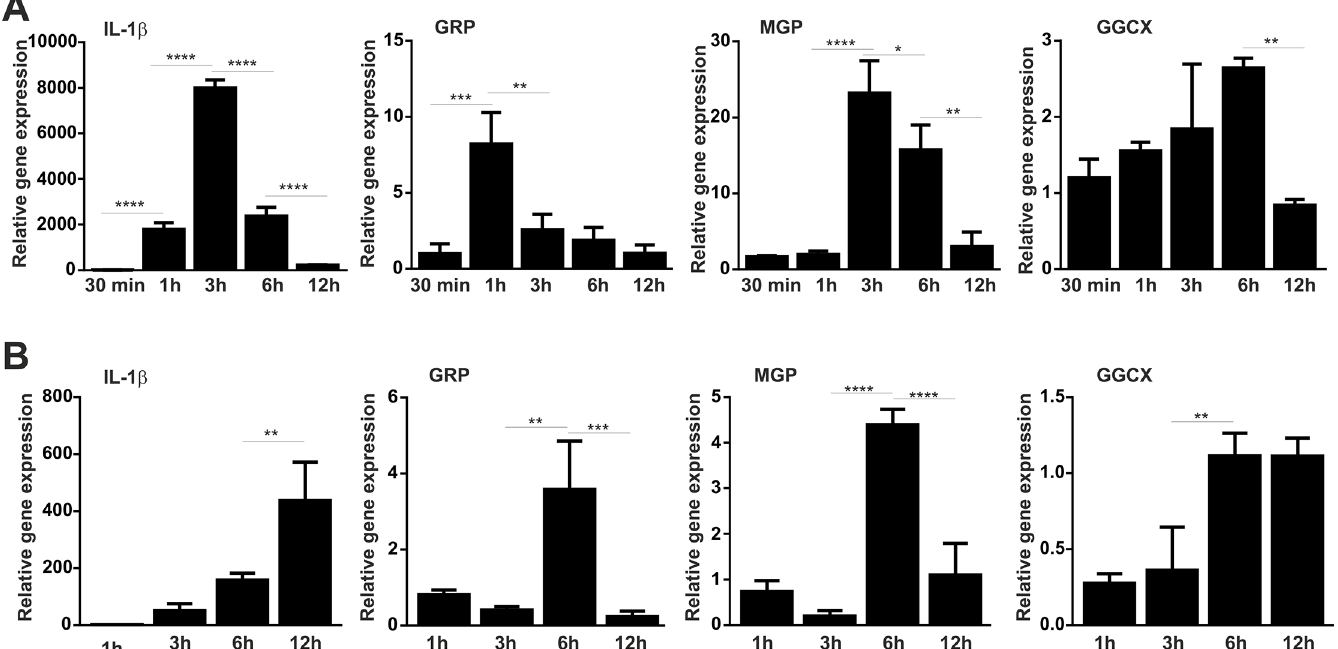
Fig 3. GRP and MGP are up-regulated in LPS stimulated THP-1 cells. THP-1 and differentiated THP-1 macrophage cells were stimulatedwith 100 ng/ ml of LPS and harvestedfor RNA extraction at determined time points during12h. Relativegeneexpressionanalysisof the inflammatory marker IL-1 β , GRP, MGP and GGCX was determinedby qPCR in monocytes(THP-1 cells) (A) and in differentiated THP-1 macrophages (B) at indicatedtime points. Gene expressionlevels are relativeto the expressionof control untreatedcells duringeach time point. GAPDH was used as housekeeping gene and data is presented as means (n = 4) ± standard error of duplicatesof two independentexperiments. Ordinary one-wayANOVA was used and multiple comparisons were achievedwith Tukey’s test. Statistical significancewas definedas P < = 0.05 ( * ), P < = 0.01 ( ** ), P < = 0.001 ( *** )and P < 0.0001( **** ).